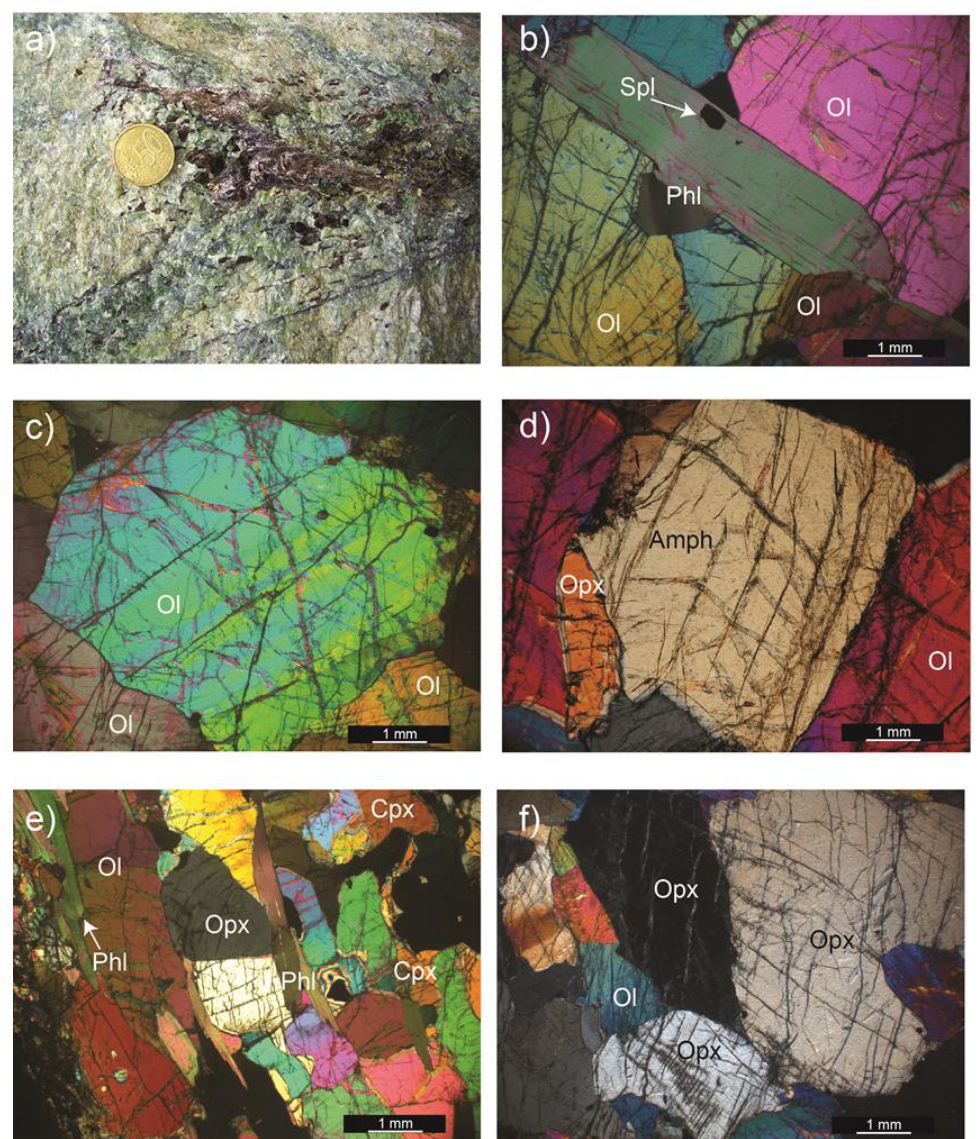
Figure 2. Petrographic and microstructural features in the coarse-grained ultramafic samples of the Ph-Pd unit (crossed polarizers). Mineral abbreviation after [35]. ( a ) Harzburgite at mesoscopic scale: pocket with large flakes of phlogopite (dark-brown), olivine (pale green), Cr-diopside (emerald green), and pargasite (dark spots); ( b ) Typical phlogopite (phl) elongated grain surrounded by olivine (ol) crystals in dunite (17); ( c ) Very coarse olivine grains with polygonal, equiaxed shape in dunite (17); ( d ) Very coarse amphibole grain with polygonal shape surrounded by olivine crystals in harzburgite (20C); ( e ) Mineral assemblage characterized by rounded crystals of orthopyroxene, olivine, and elongated phlogopite crystals, which mark the foliation in lherzolite (08B); ( f ) Anhedral orthopyroxene grain with cusp-like terminations in harzburgite (24C).